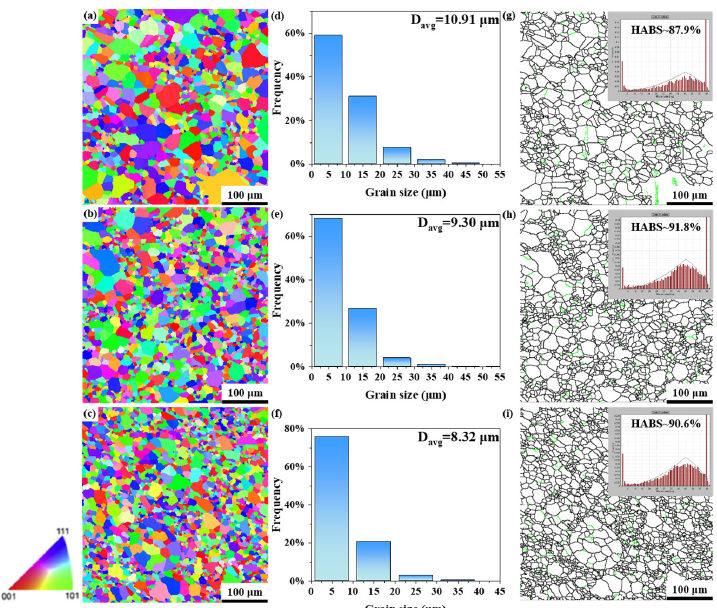
Figure 12. Inverse pole figure and Frequency histogram of grain together with distribution of grain boundary misorientation in as sintered Sc-doped RR1000: ( a , d , g ) 0 wt.% Sc, ( b , e , h ) 0.048 wt.% Sc, ( c , f , i ) 0.064 wt.% Sc. Green lines represent the low angle boundaries (LABs) (0–15°) but the high angle boundaries (HABs) (>15°) were indicated by black lines.